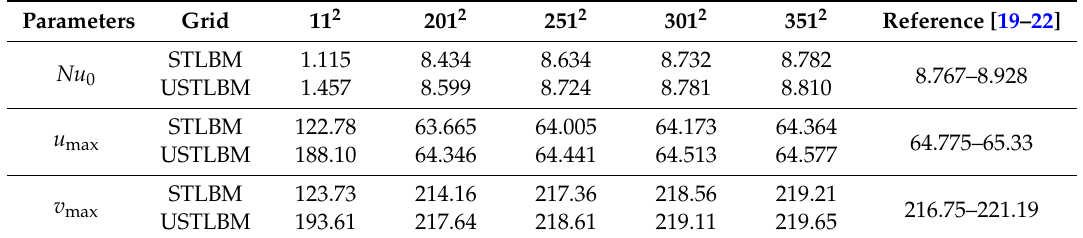
Table 2. Comparisons of flow parameters in Ra = 10 6 at different mesh sizes.